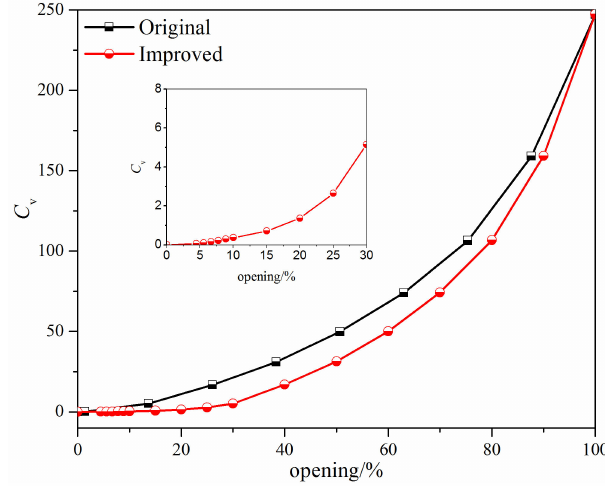
Figure 7. The flow characteristics of the improved V-ball valve.